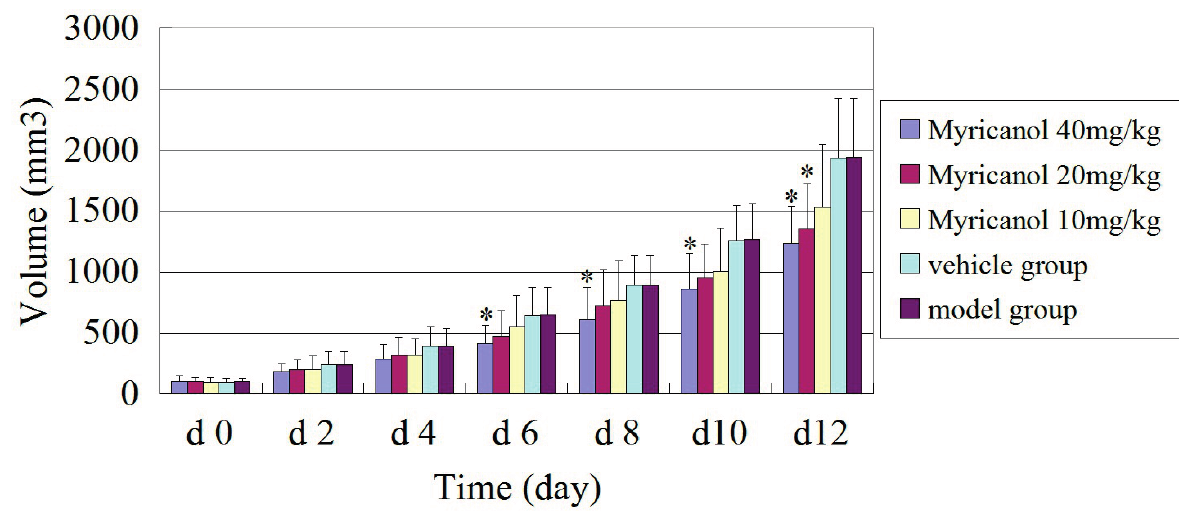
Figure 1. Growth curve of tumor volume. Tumor xenografts from A549 cells were established in athymic nude mice in the flanks and treated with either myricanol or PEG-400 (vehicle control) for 14 days consecutively. Tumor volume was measured with Vernier caliper and calculated. * Compared with the vehicle group, p <